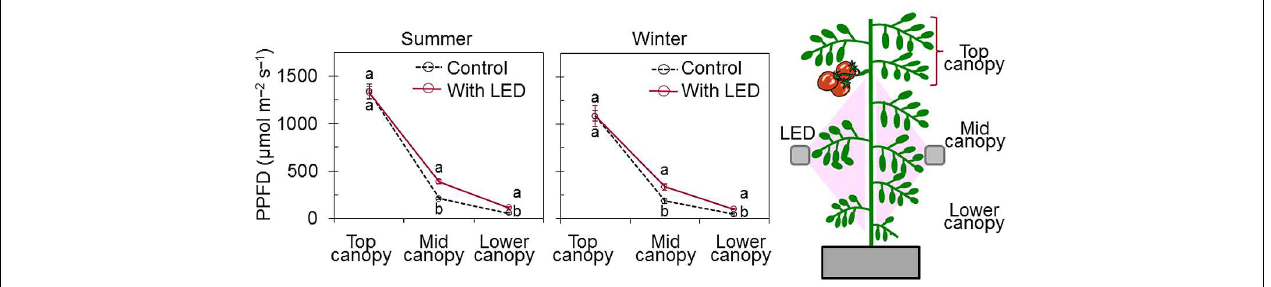
FIGURE 1 | Effect of LED inter-lighting on photosynthetic photon flux density (PPFD) along the profile of tomato plant canopy (top, middle, and lower canopy). PPFD was measured by using a quantum sensor positioned at the inclination angle of representative canopy leaves near the point of measurement. Data represent means ± SE ( n = 10). For each canopy level, different letters indicate statistically significant differences ( t -test at P <